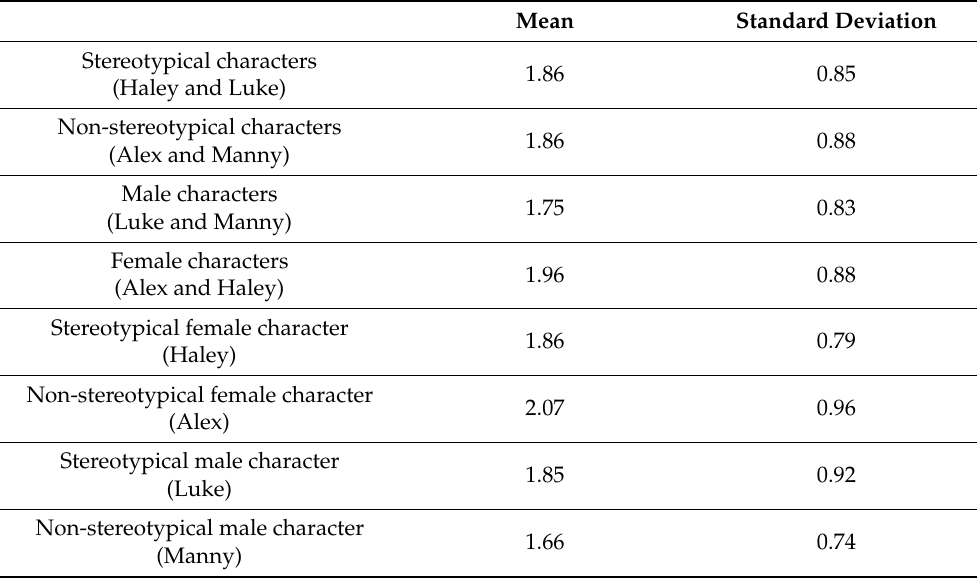
Table 5. Means and standard deviations of parasocial love with various character